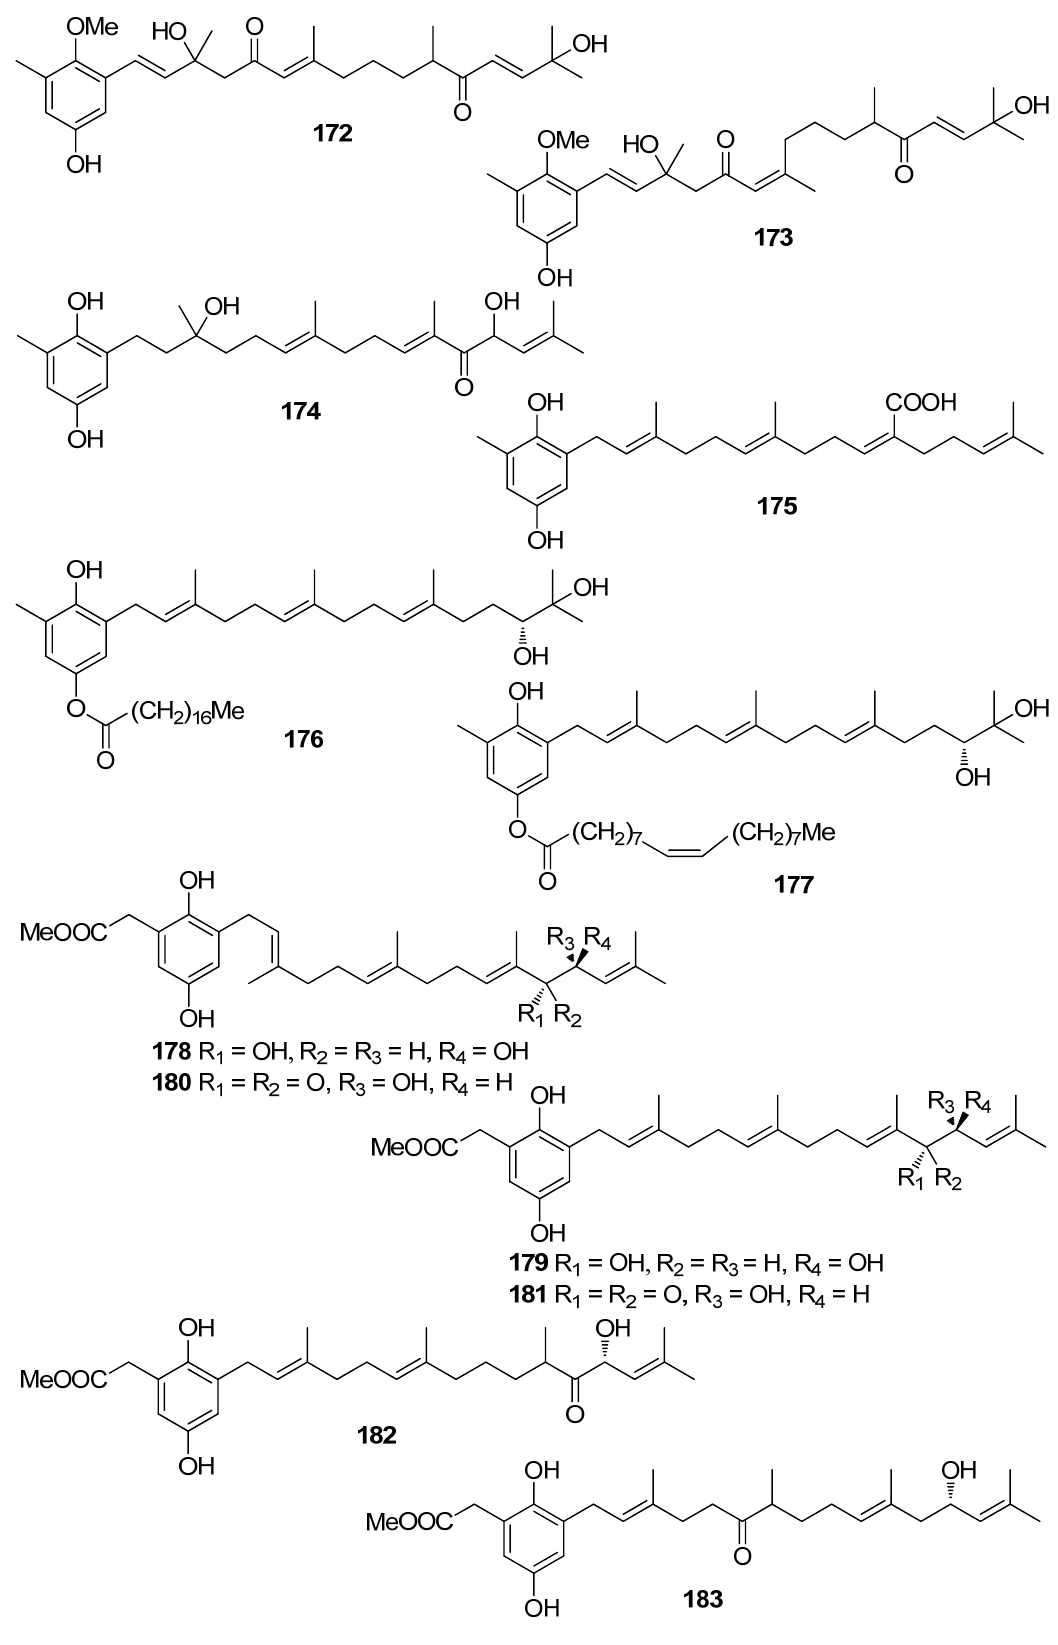
Figure 16. Chemical structures of compounds 172 – 183 .